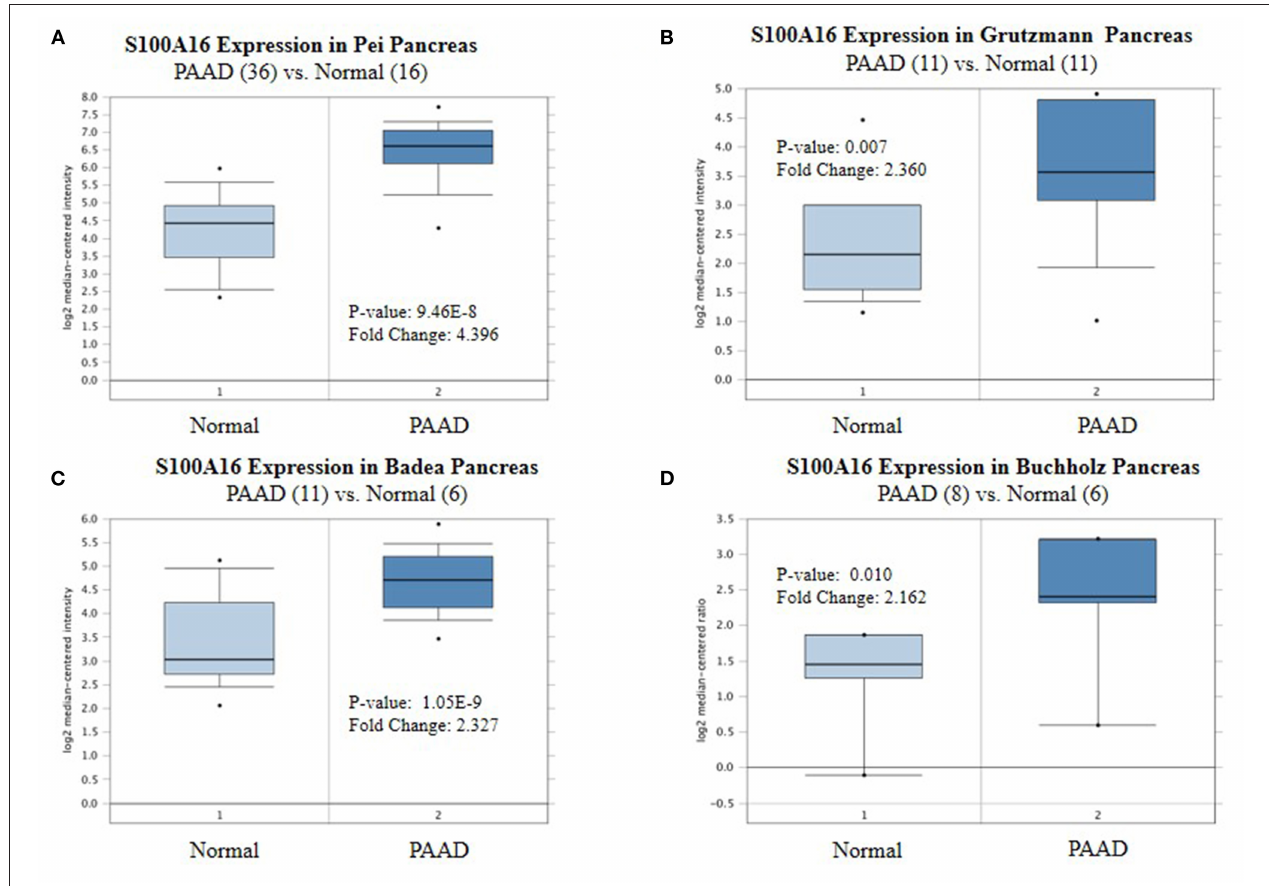
FIGURE 3 | Expression level of S100A16 in each study based on Oncomine. (A) Pei pancreas, (B) Grutzmann Pancreas, (C) Badea Pancreas, (D) Buchholz Pancreas, Top 10% refers to the top10% of genes; P <